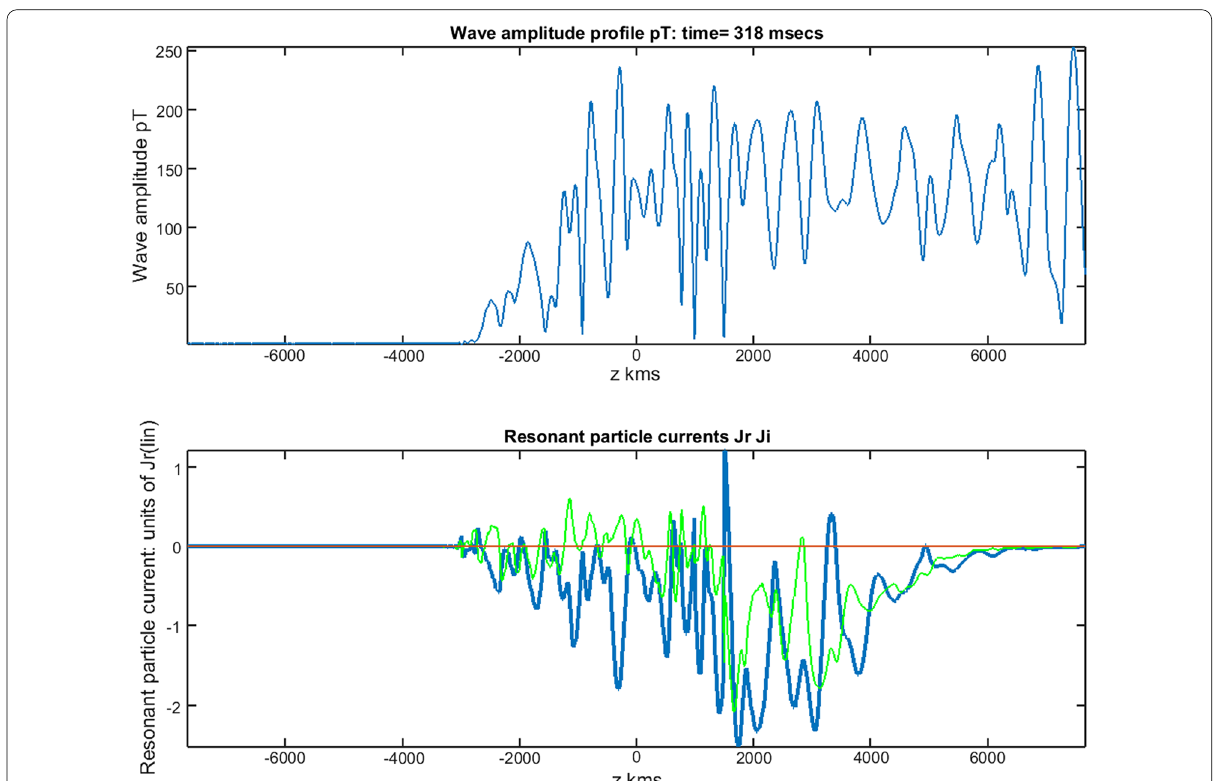
Fig. 4 Time snapshot of the generation region of a strong riser from the previous simulation. The graphs show wave amplitude, resonant particle current Jr in phase with the wave electric field (blue curve) and current Ji in phase with the wave magnetic field (green curve). Note the strong sideband activity. The overall shape of the current curves is as expected for trapping in a parabolic inhomogeneity. Although the generation region is in the equatorial zone, the wave profile extends upstream from the equator by some 2000 km